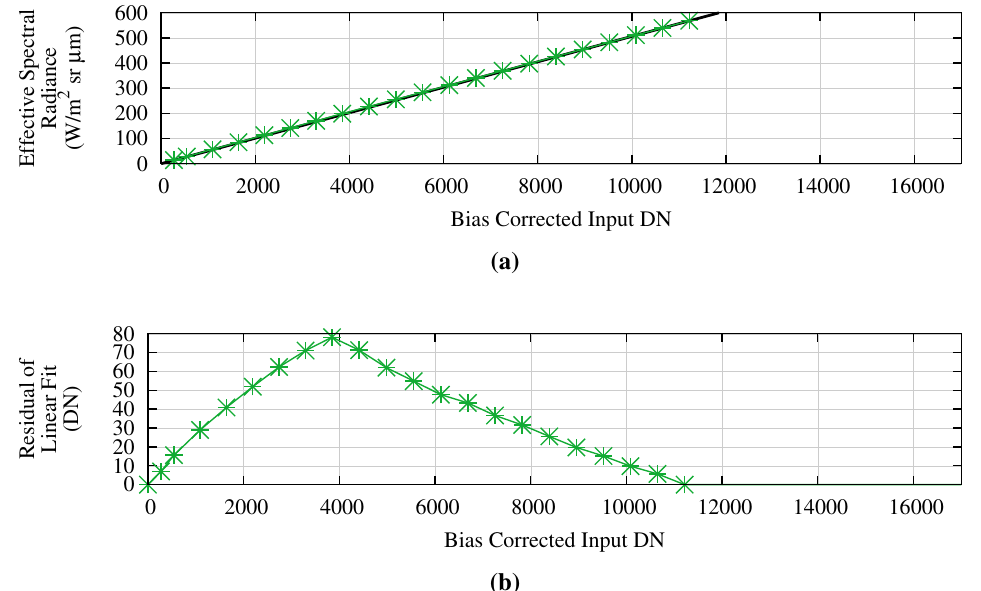
Figure 15. Example of pre-launch integration time sweep data showing ( a ) the linearity and ( b ) the residual non-linearity of a single detector in the green band. The linear fit is constrained forcing zero residuals at 0 DN and at the maximum tested radiance